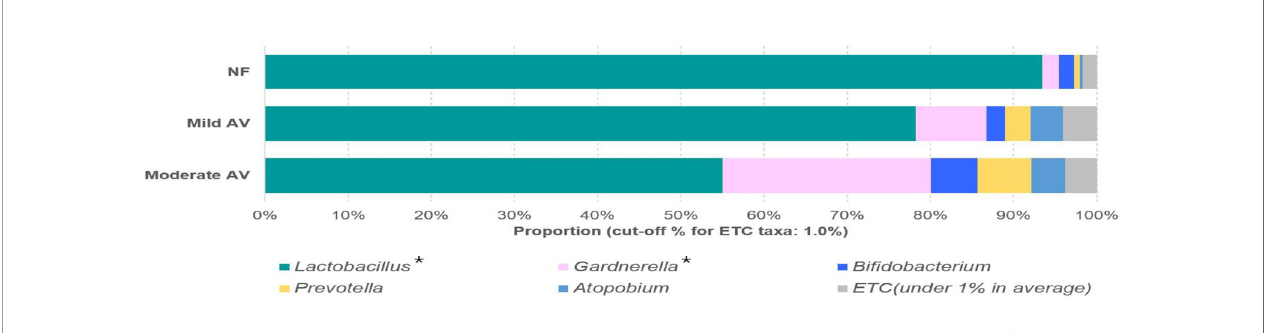
FIGURE 1 | Relative abundances of the three groups, including normal fl ora, mild aerobic vaginitis, and moderate aerobic vaginitis. Average taxonomic compositions at the genus level among the subjects categorized into the three groups based on the aerobic vaginitis scoring system. The proportion of the bacterial composition was presented at a cut-off of ≥ 1.0%. Asterisk indicates signi fi cance between groups (* p < 0.05) as determined using the Kruskal – Wallis test.